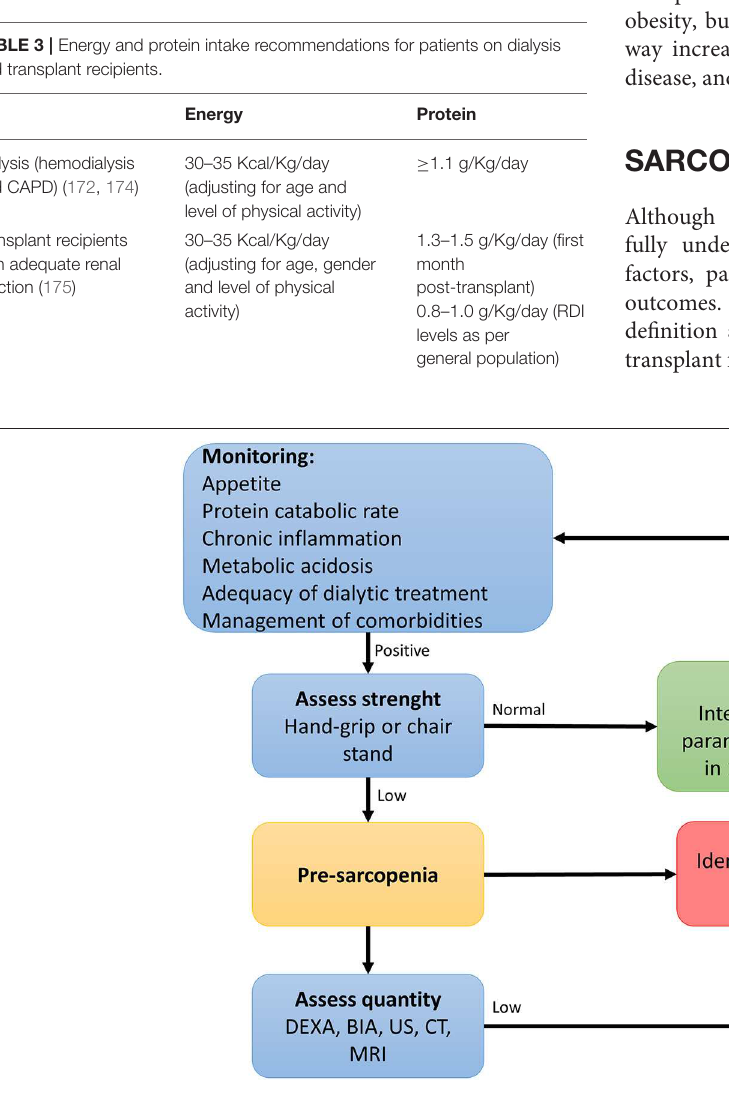
Frontiers in Nutrition |